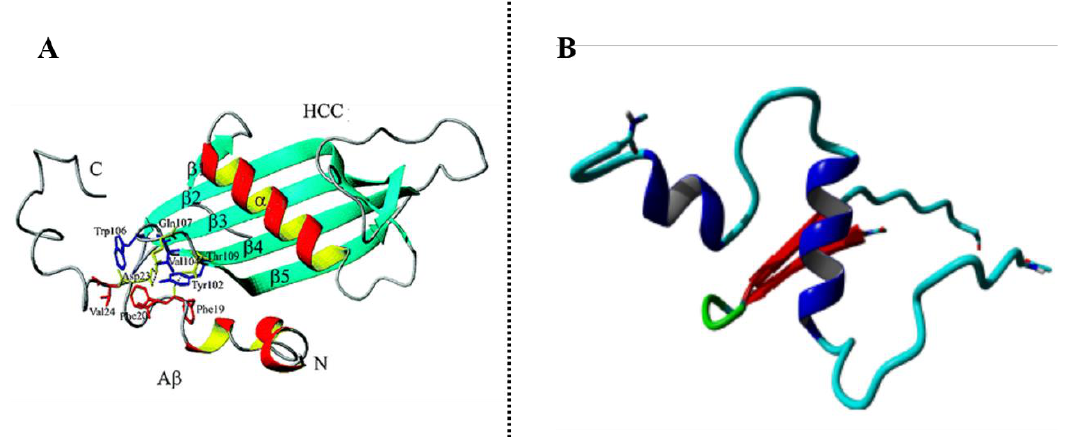
Figure 6. ( A ) Interaction structure of the CysC-A β complex revealed by molecular dynamics simulation Figure 6. A ) Interaction structure of the CysC-Aβ complex revealed by molecular dynamics in the study of Przybylski et al. [186] ( B ) The binding complex from the docking output between A β simulation in the study of Przybylski et al. [186] B ) The binding complex from the docking output and CysC fragment in the study of Sharma et al. between Aβ and CysC fragment in the study of Sharma et al. [188].